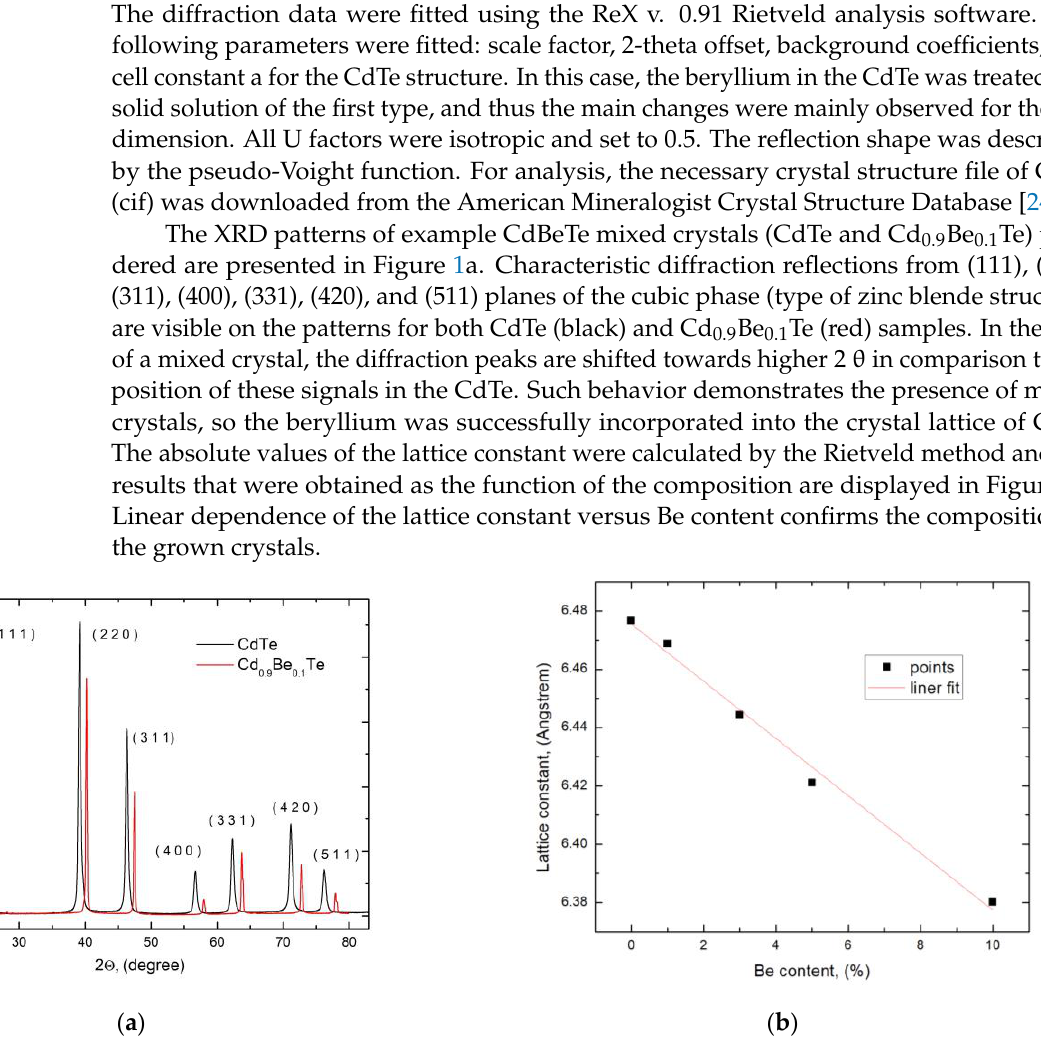
Figure 1. The XRD patterns of CdTe (black) and Cd 0.9 Be 0.1 Te (red) powders ( a ) and lattice constant versus beryllium concentration ( b ).